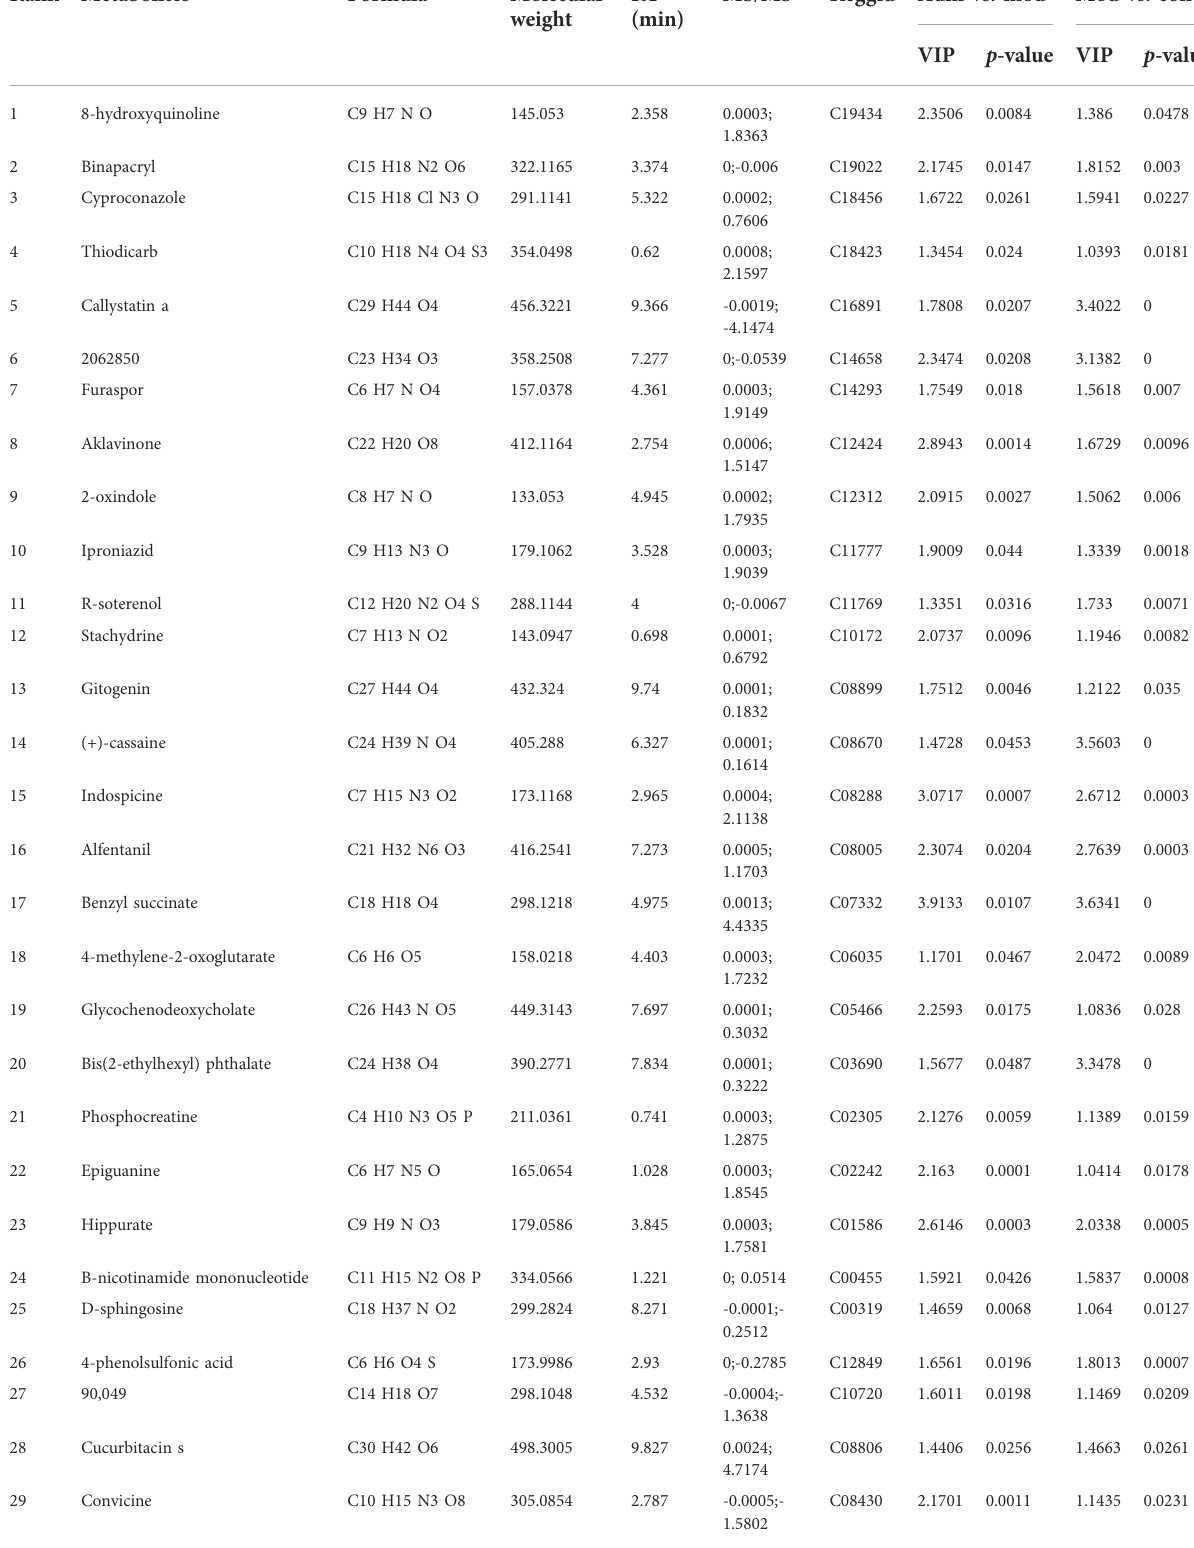
TABLE 1 The differential metabolites in DP-treated DFU